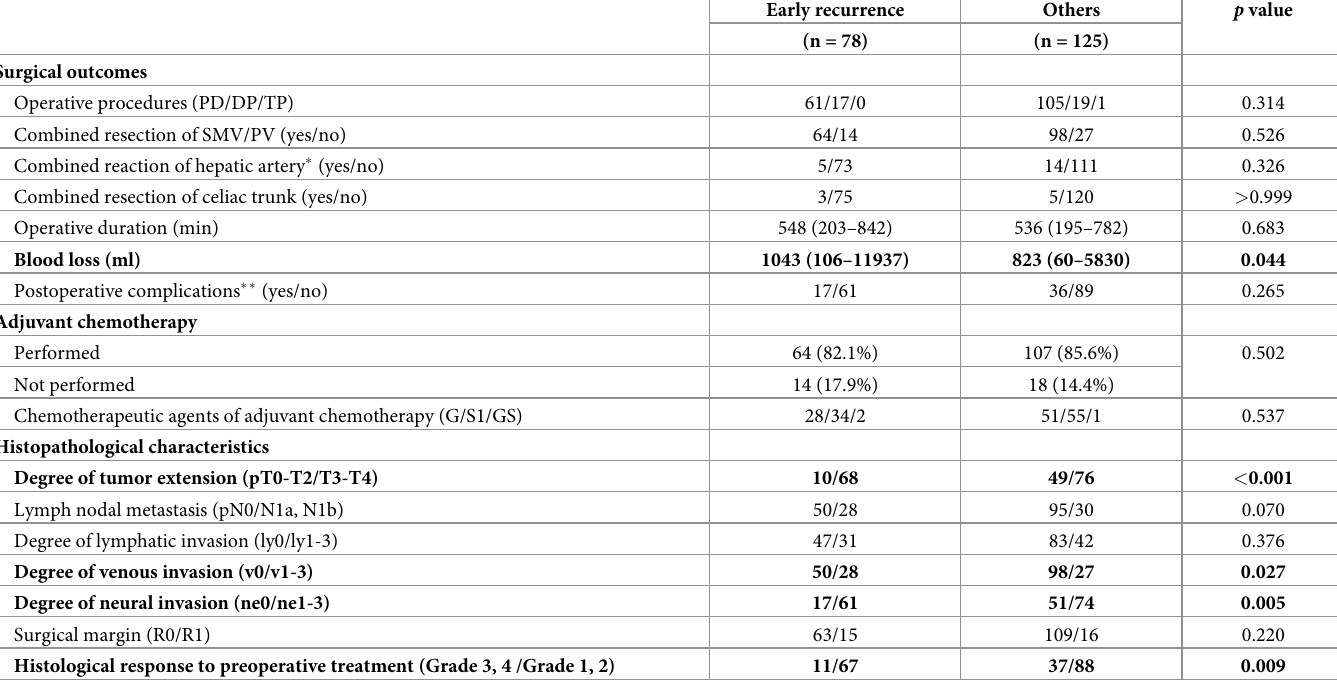
Table 3. Surgical outcomes and histopathological characteristics in the localized pancreatic cancer patients with curative-intent resection after preoperative CRT according to the occurrence of early recurrence after surgery.